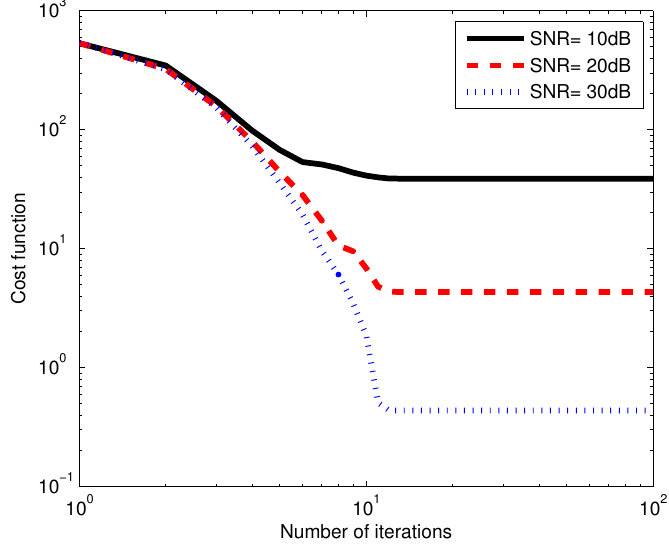
Figure 2. Cost function versus the number of